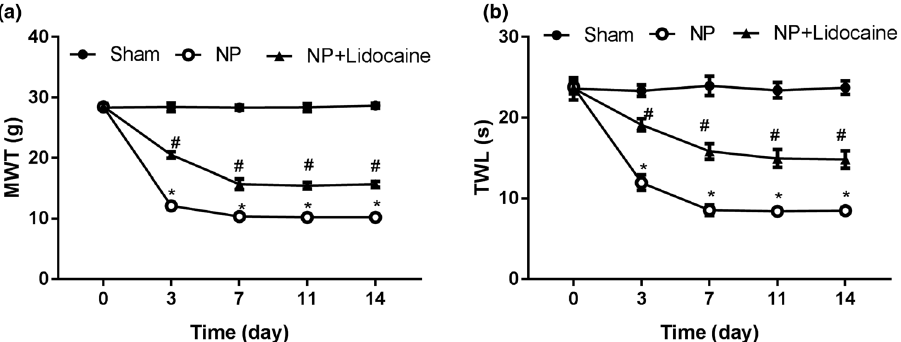
Figure 1: Lidocaine ameliorates CCI - induced NP: ( a ) The value of MWT was detected in NP rats at 3, 7, 11, and 14 days. ( b ) The value of TWL was detected in NP rats at 3, 7, 11, and 14 days after induction of CCI. N = 10. Data are expressed as mean ± SD and were analyzed using one -